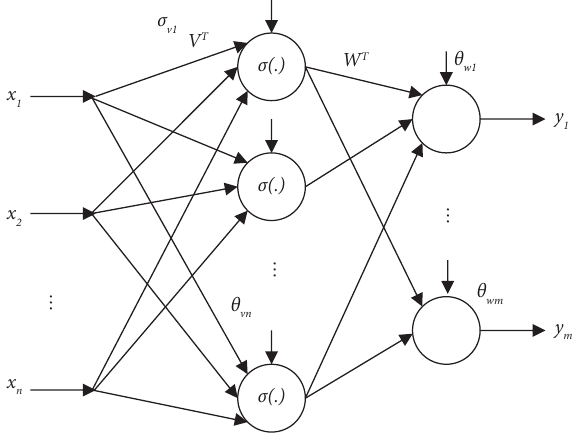
Figure 2: Feedforward neural